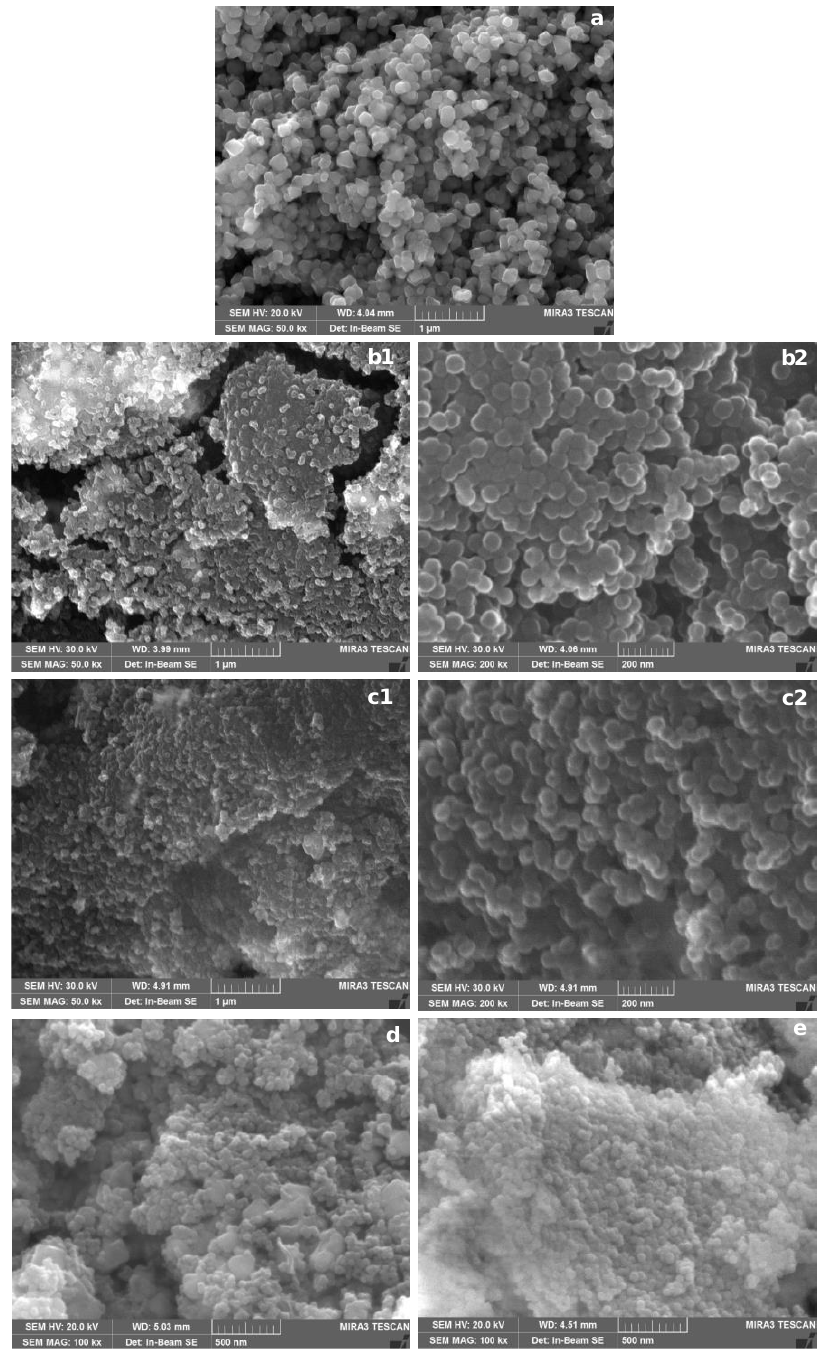
Figure 1. Representative scanning electron microscopy (SEM) images acquired on ( a ) pristine Fe 3 O 4